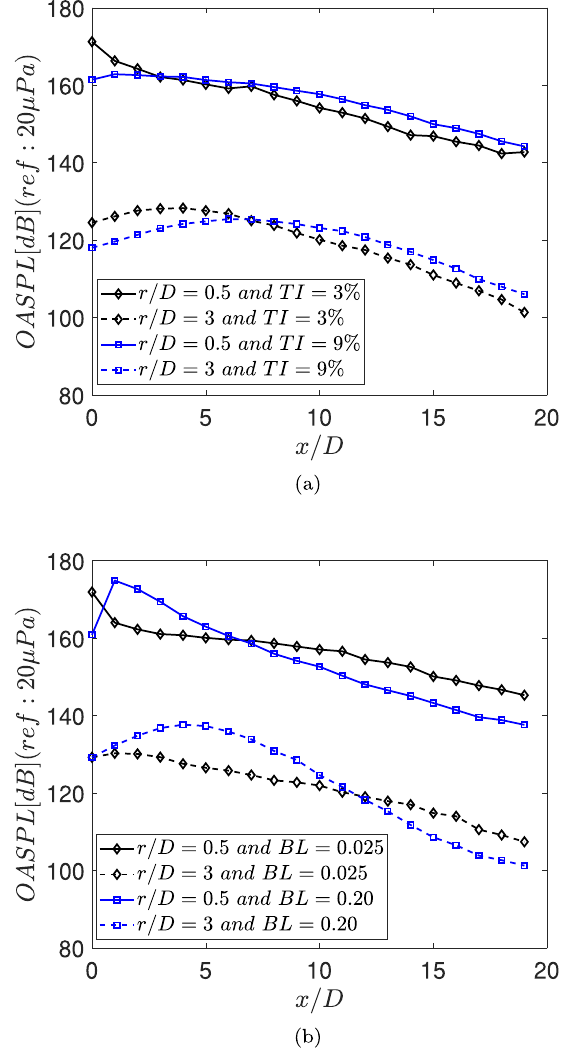
Figure 5. OASPL axial evolution at radial locations 0.5 D and 3 D : (a) different TI and (b) different d